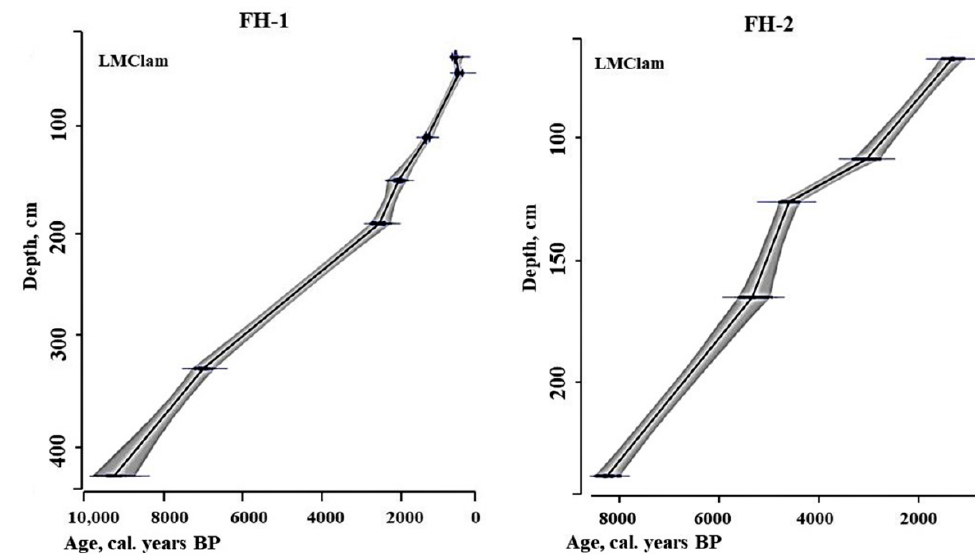
Figure 1. Model of the rate of vertical growth of studied peats (depth to age).